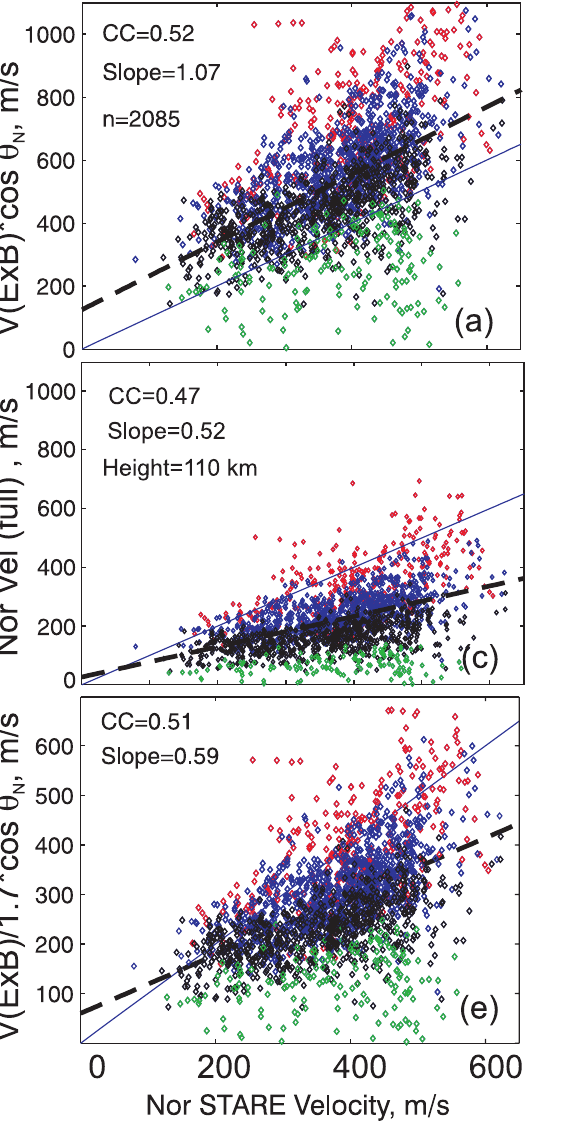
correlation coefficients and slopes are not close to 1.